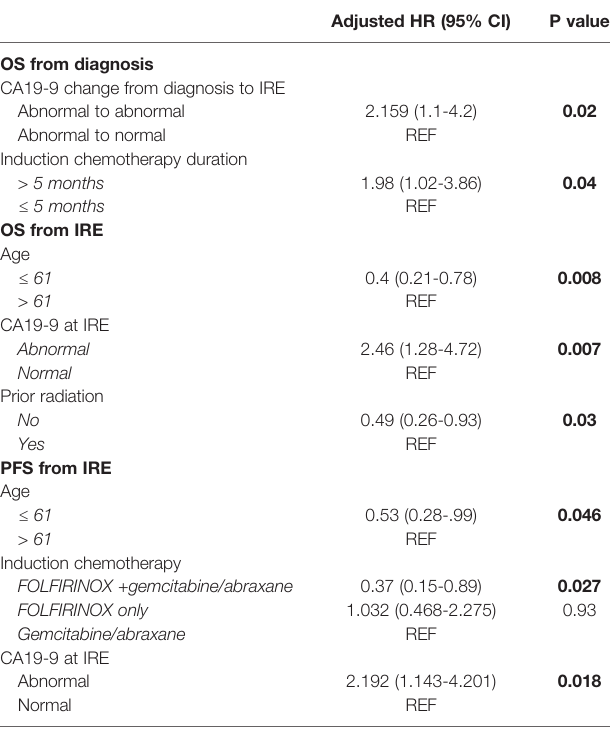
TABLE 5 | Independent risk factors for survival in locally advanced pancreatic cancer